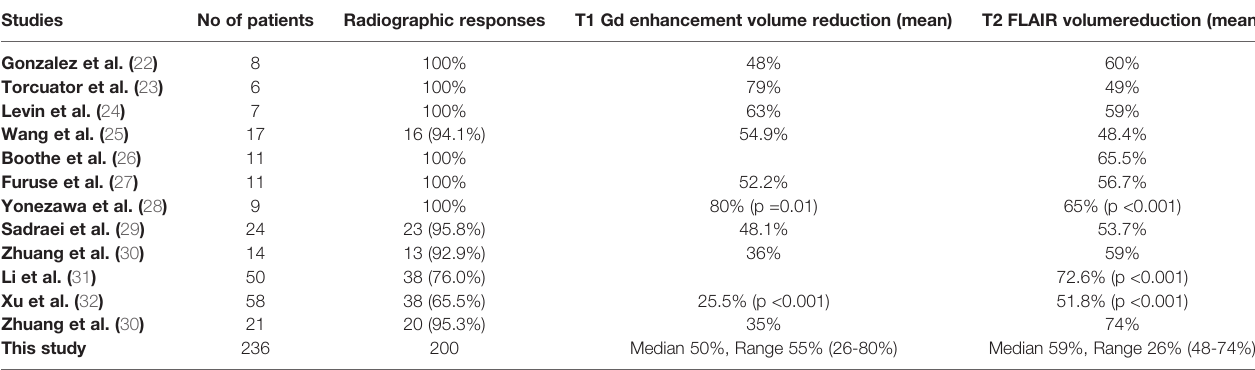
TABLE 4 | Radiographic responses and MRI changes after treatment with bevacizumab. Studies